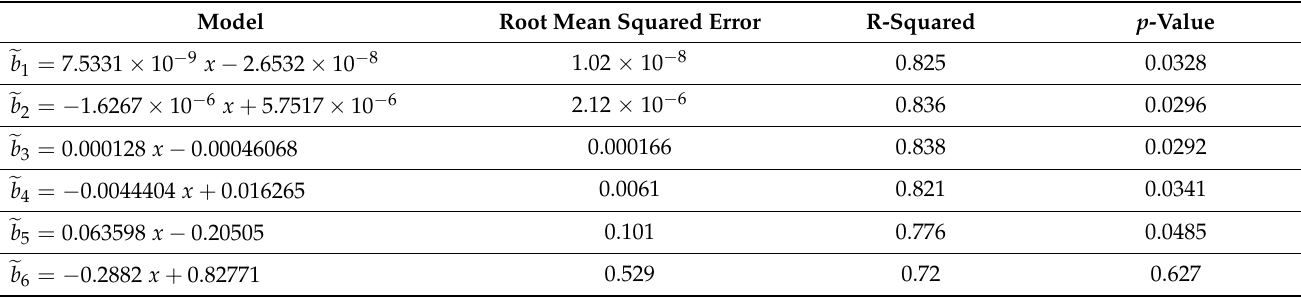
Table 18. Models and statistics (procedure 5).